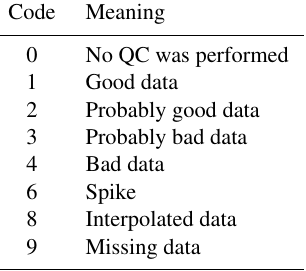
Table 2. Quality control